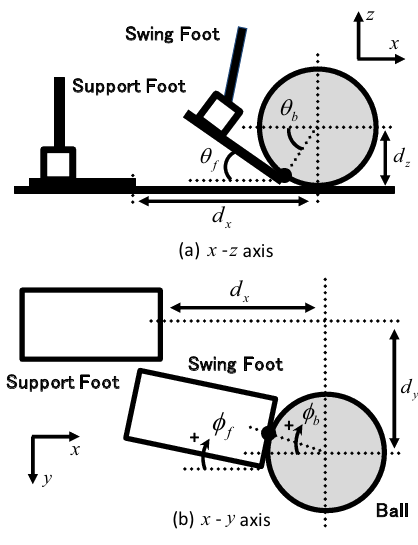
Figure 4. Experimental environment of the kicking motion ( d : distance from the center of the ball to the toe of the support foot; θ f , ϕ f : angles of the swing foot relative to the horizontal and vertical axes; θ b , ϕ b : angles of the line between the center of the ball and the contact point).